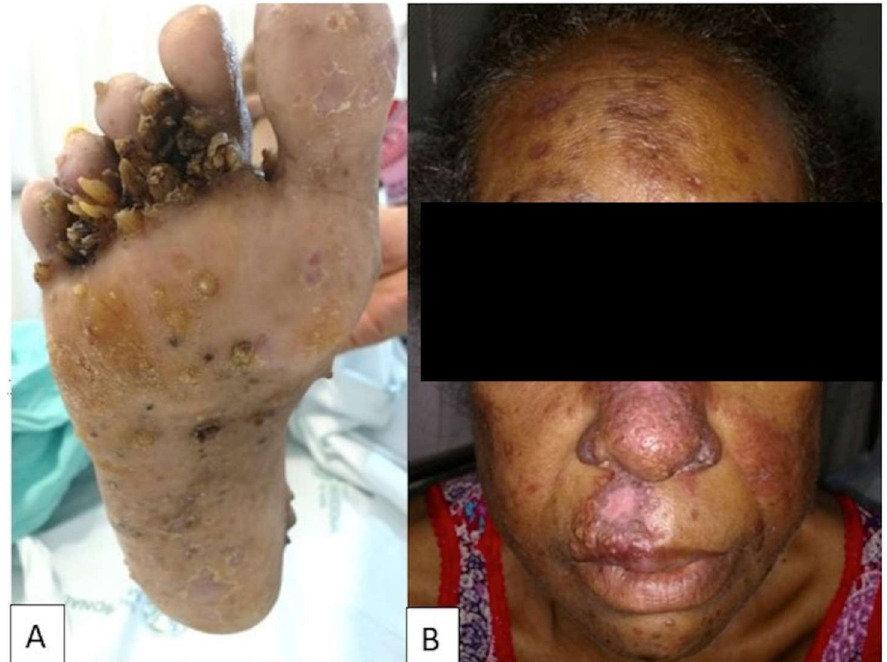
Figure 1. Skin involvement in PCM-HIV coinfection. ( A ) Verrucous lesions on the foot caused by hematogenous dissemination. ( B ) Papulonodular ulcerative lesions caused by hematogenous dissemination. Illustration provided by Prof. Paulo Mendes Peçanha from Infectious Disease Unit, Universidade Federal do Espírito Santo.